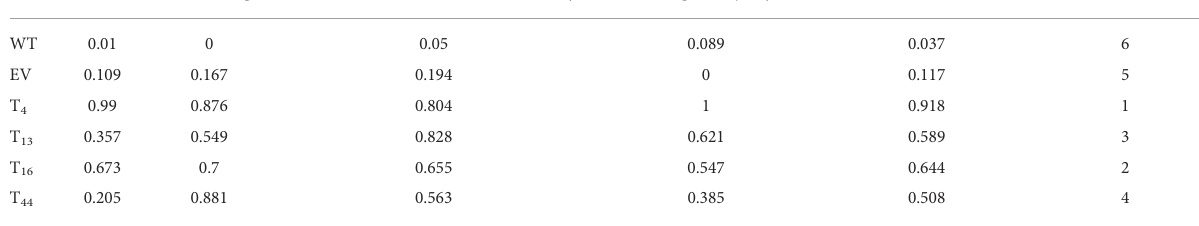
TABLE 1 Membership function values and evaluation index of the drought resistance of TaDREB2B-transgenic sugarcane. Lines Membership function value Syntheticevaluation Drought resistance